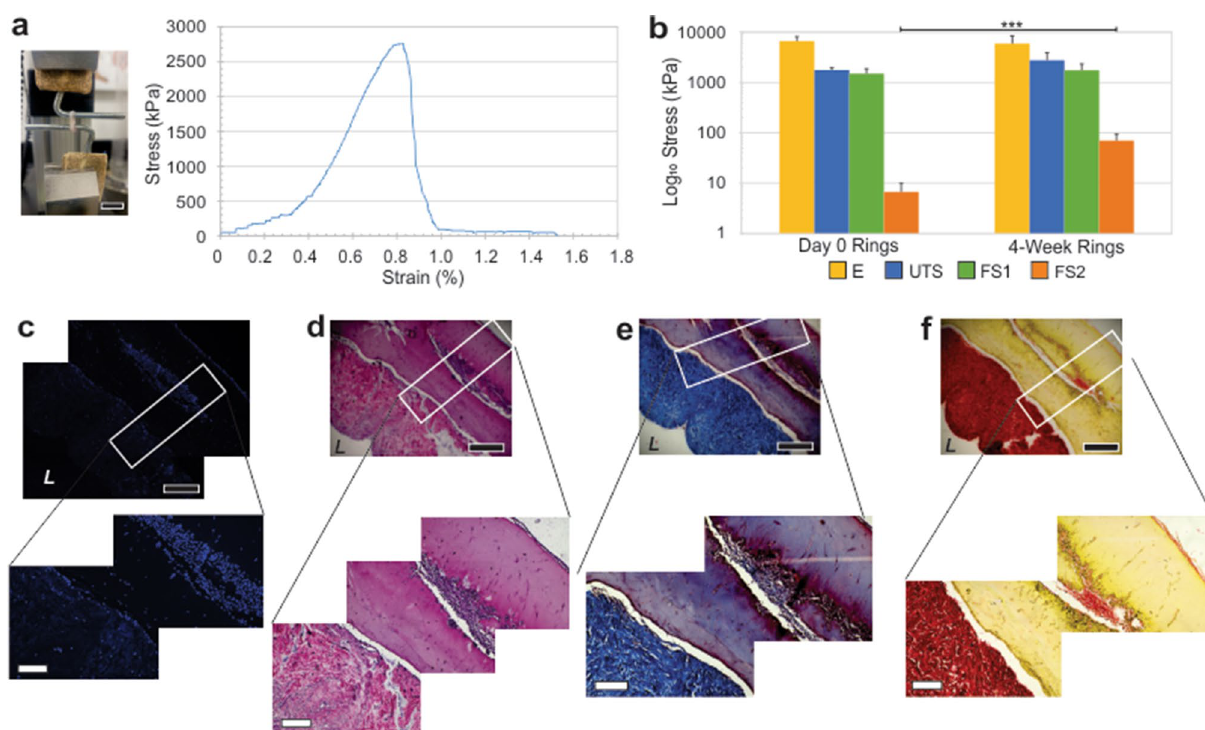
Figure 9. Engineered Alloderm rings exhibit long-term viability. Alloderm-integrated rings cultured for 4 weeks showed retainment of mechanical integrity. ( a ) A 4-week cultured Alloderm ring sample in the tensile setup with the associated average stress–strain curve. ( b ) Average elastic modulus (E), ultimate tensile strength (UTS), failure strength 1 (FS1), and failure strength 2 (FS2) for the day 0 and 4-week rings showing mechanics were maintained over the 4 week period; in fact, FS2 significantly increased after 4 weeks in culture indicating development of ECM strengthening the tissue. Histological analyses of 4-week rings stained for ( c ) fluorescence DAPI, ( d ) H&E, ( e ) Masson’s Trichrome, and ( f ) picrosirius red showing maintenance of tissue integrity and cellularity over time. Black scale bars = 500 µm; white scale bars = 200